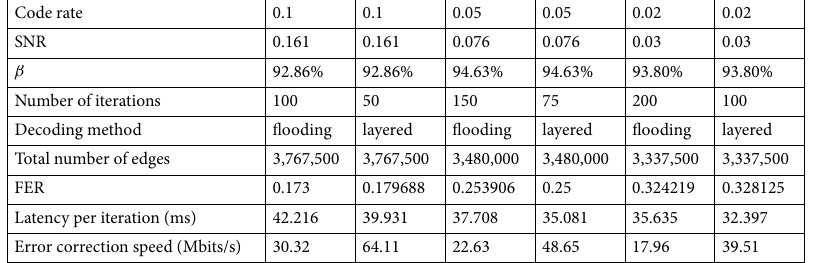
Table 2. Performance comparison between the flooding and the layered BP decoders with GPU implementation.